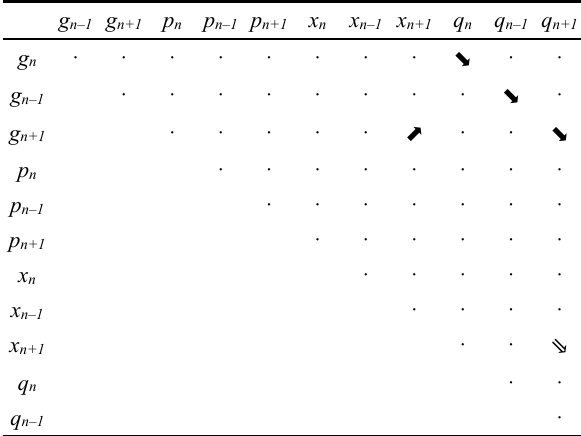
Table 5 Covariance Matrix for the Single Fixation Durations